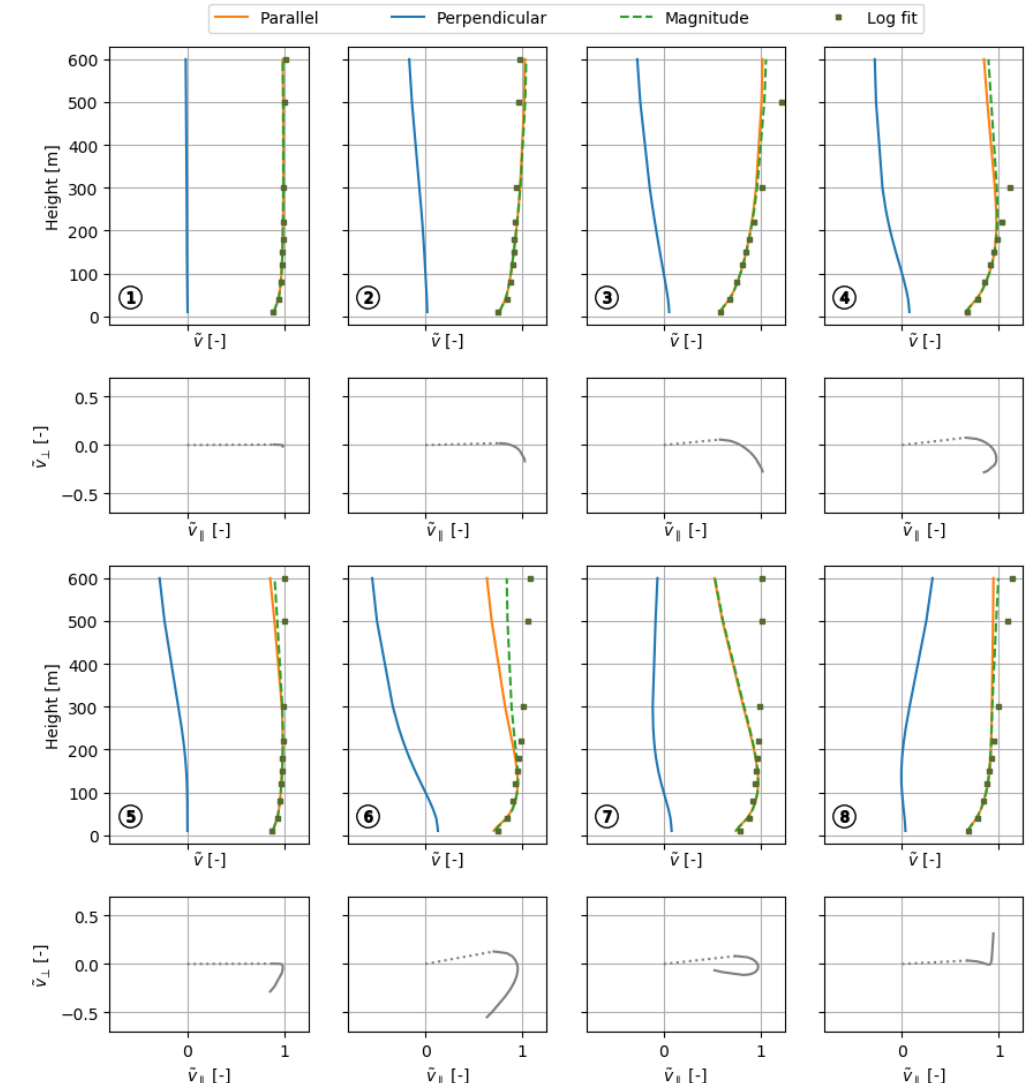
Figure 8. The eight cluster-mean wind profile shapes of the offshore clusters (MMIJ-1–8). Each shape is depicted by the normalised wind speed components with height (first and third rows) with the corresponding hodograph below (second and fourth rows). Non-adiabatic logarithmic profile fits are plotted alongside the shapes. In each hodograph, the lower end of the profile is indicated by the dotted line connecting the lowest-height point to the origin. All plots share the same x axis.